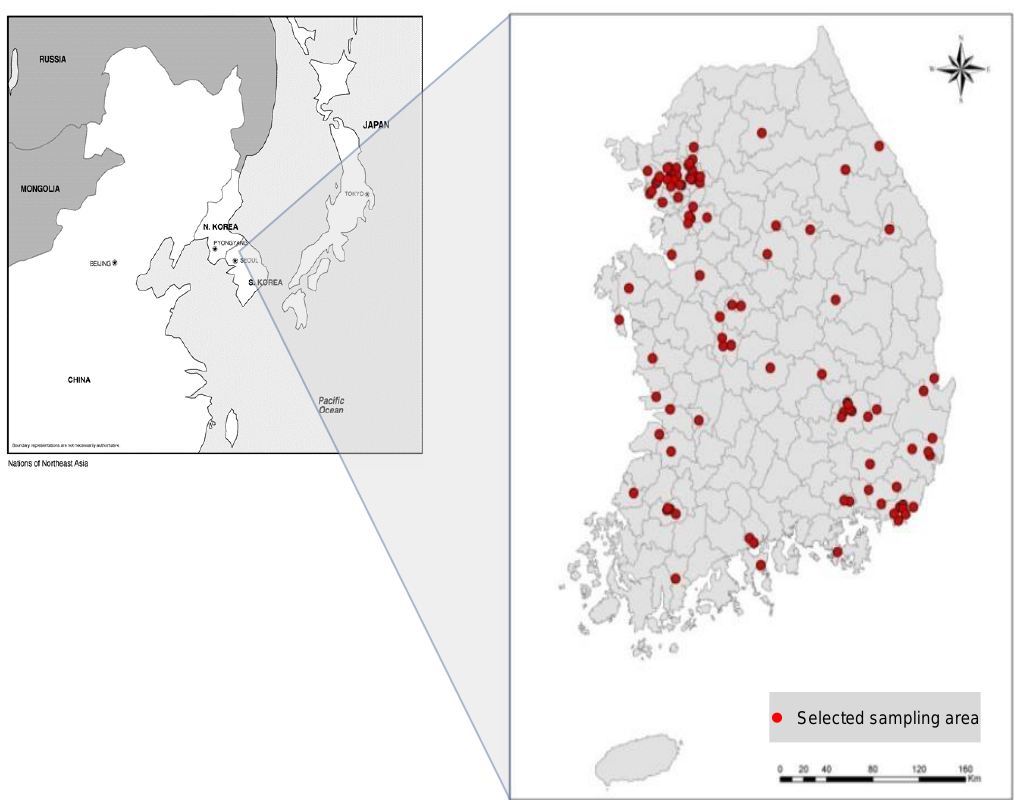
Figure 2. A total of 2139 persons from 98 units participated in the human biomonitoring survey.